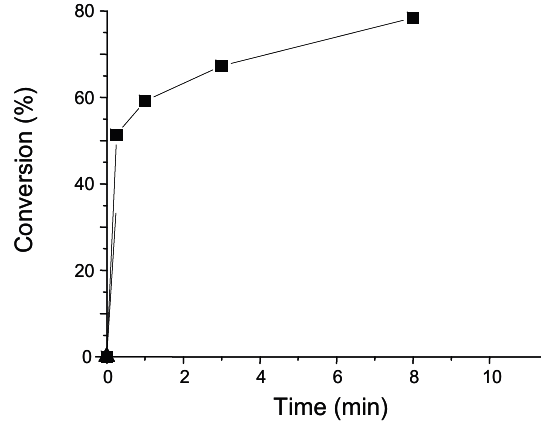
Figure 3. Photopolymerization profile of an epoxy acrylate formulation (Ebecryl 605) using the BAPO/(TMS) 3 SiH (2%/3%, w/w) photoinitiating system upon a sunlight exposure. Under